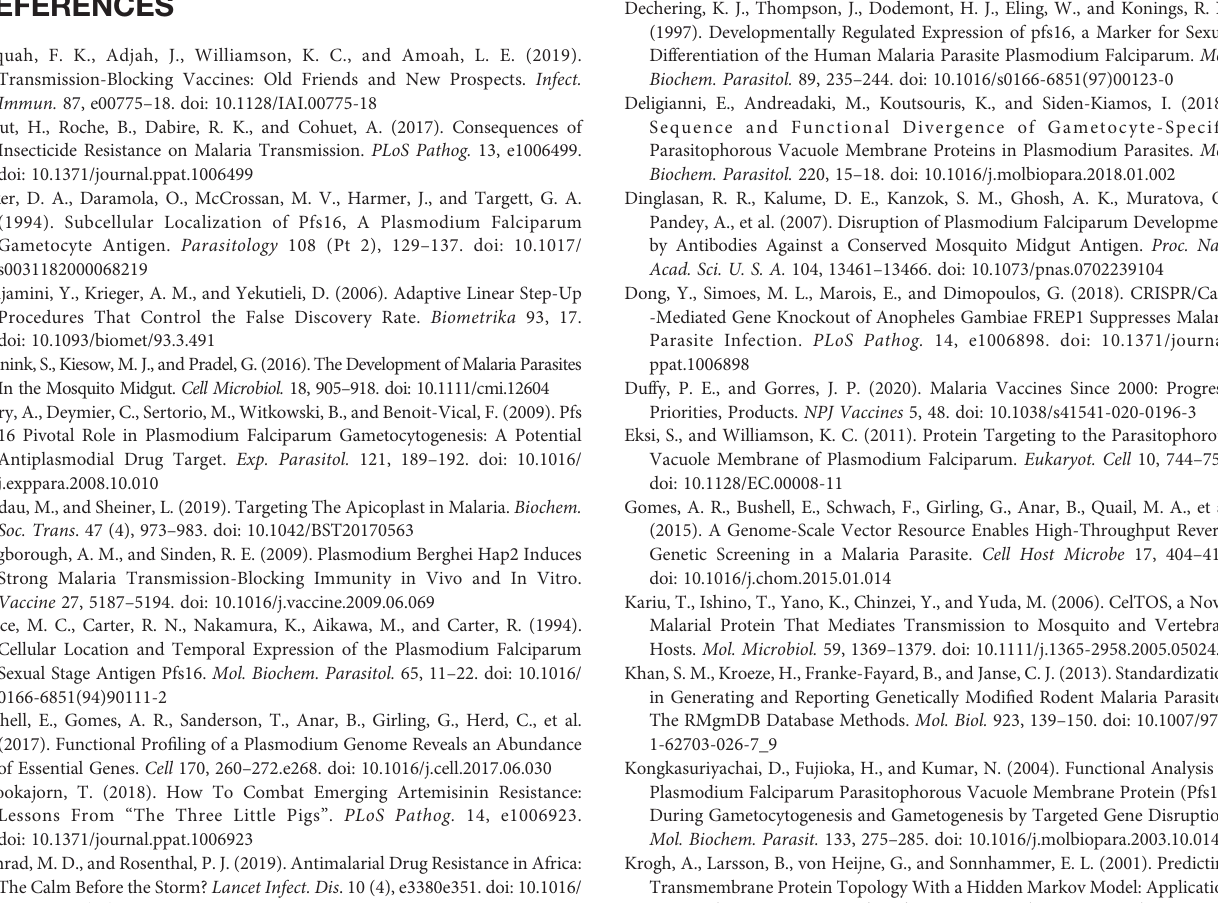
Supplementary Table 1 | Speci fi c primers for candidate genes. Supplementary Table 2 | The expression data of genes that contain transmembrane domains and lack signal peptides. Supplementary Figure 1 | The heatmap of 1,079 parasitic proteins containing signal